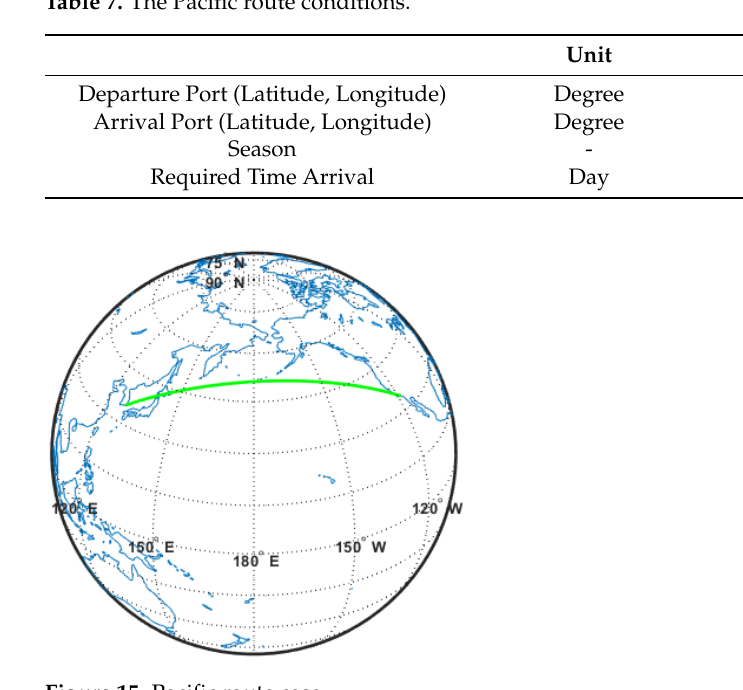
19 of 24 Table 6. Voyage results according to speed control methods. Speed Governor